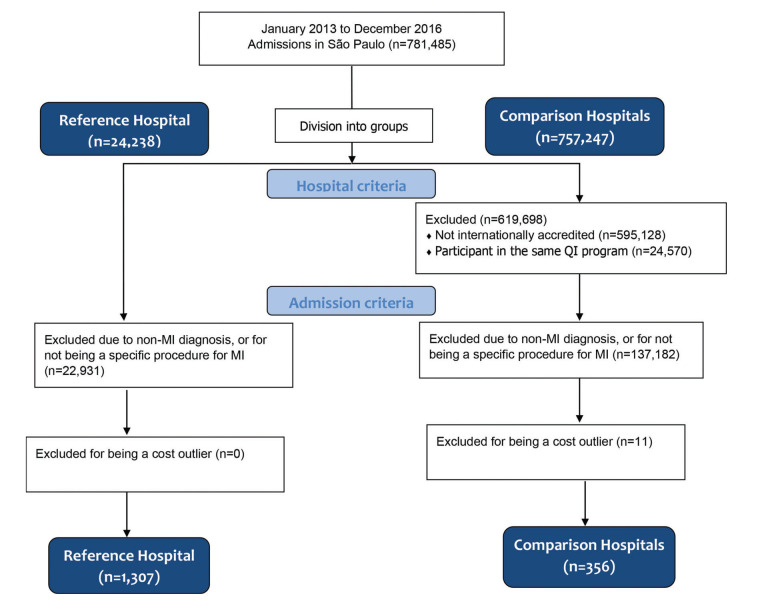
Consort diagram.